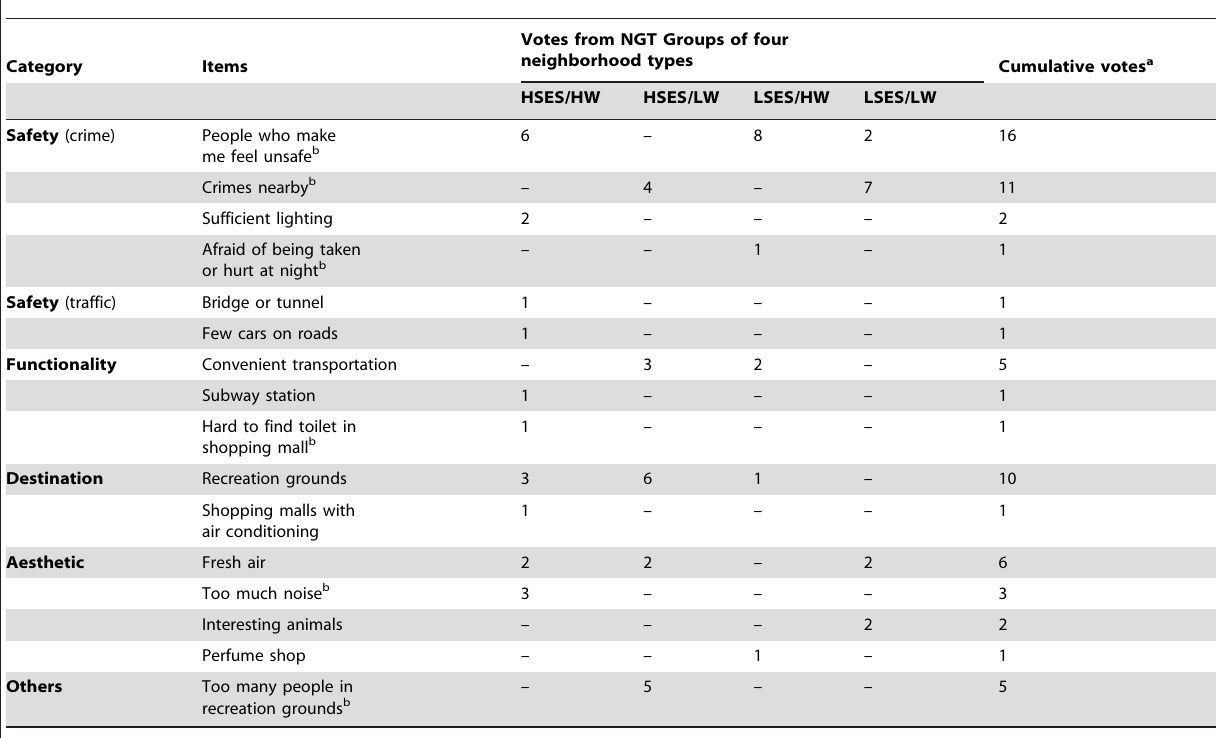
Table 3. PA-related Neighborhood Environmental Factors Identified by NGT Groups.